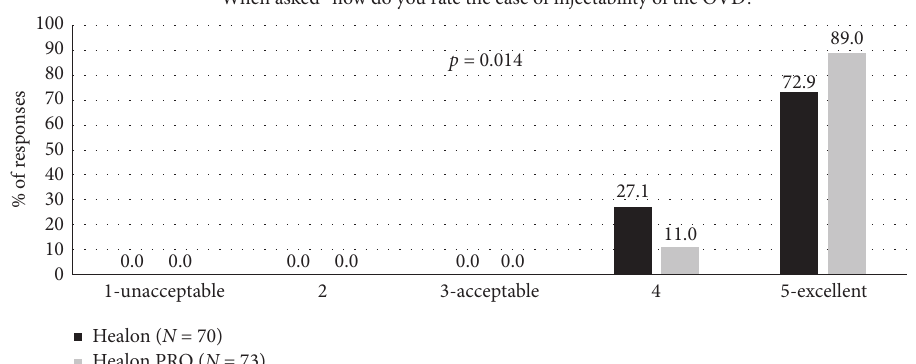
Figure 3: Ease of OVD injectability during surgery for the Healon control and Healon PRO test groups, where “user acceptable” indicated a response of “3,” “4,” or “5.”